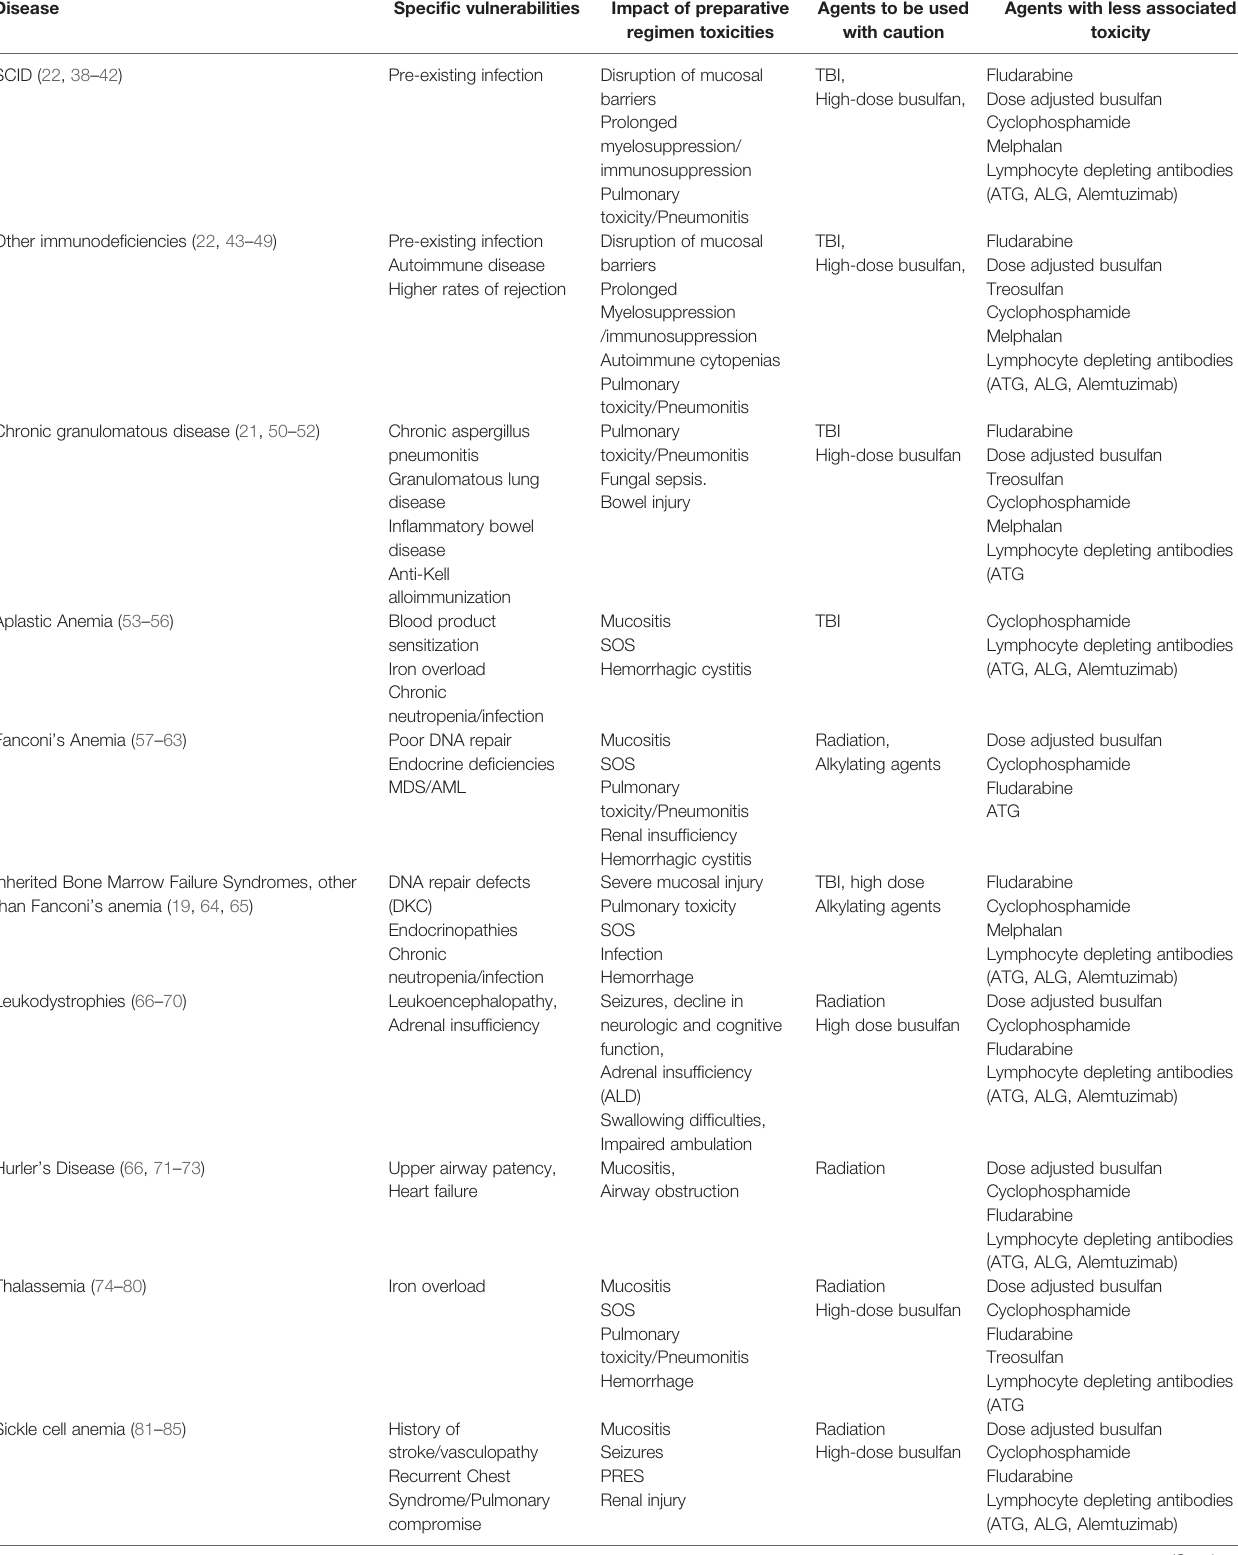
TABLE 1 | Disease-speci fi c vulnerabilities and the in fl uence of preparative regimens on HSCT course.